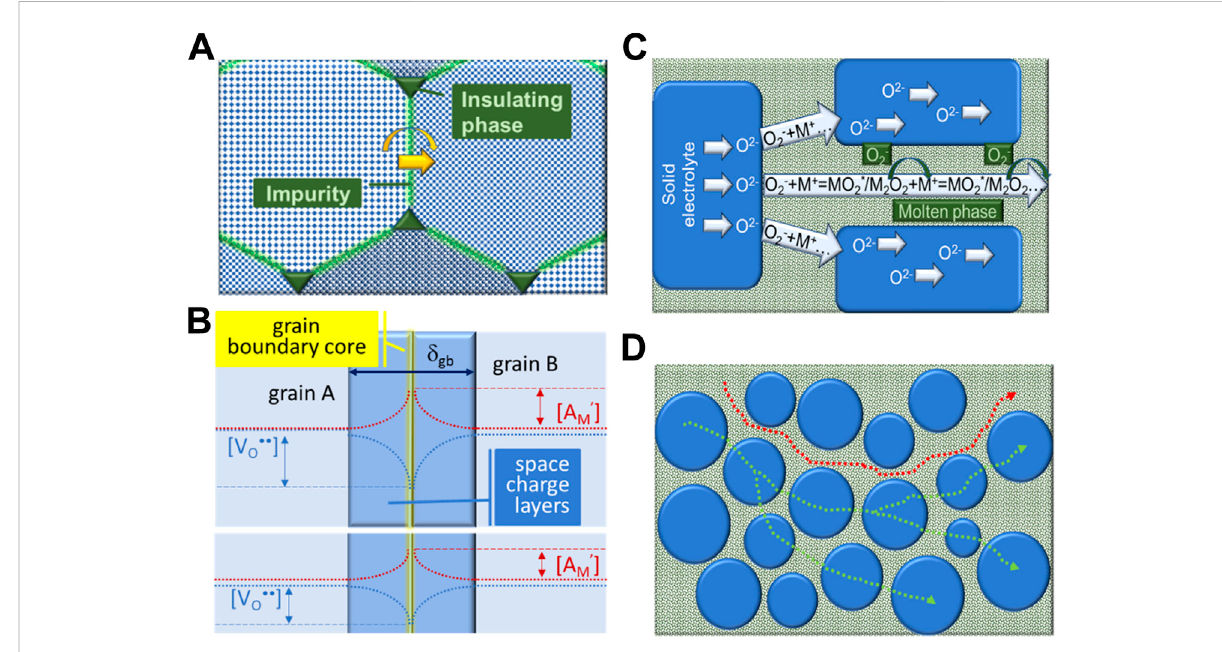
FIGURE 6 Grain boundary schemes: (A) traditional description, including crystallographic orientation mismatch between grains, impurities in the grain boundary region and insulating particles in triple contact points (Bauerle, 1969); (B) electrical grain boundary, with core, space charge layers and (cid:129)(cid:129) ]) (Guo et al., 2003; Guo and Waser, 2006). In the lower insert, concentration pro fi les of acceptor dopant ([A M ’ ]) and oxide-ion vacancies ([V O levelling of concentration pro fi les due to an extrinsic species acting as local scavenger (Zhu et al., 2014); (C) combined oxide-ion transport mechanisms, where several species might assist O 2 − transport in between grains or along the salt phase; (D) single (salt) phase and dual phase O 2 − pathways (Maheshwari and Wiemhöfer, 2016). See text for